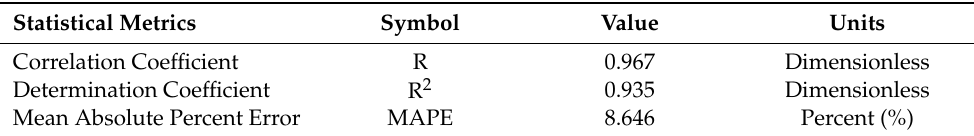
Table 6. Results of the statistical indicators used to evaluate the general adjustment of the model. Statistical Metrics Symbol Value Units Correlation Coefficient R 0.967